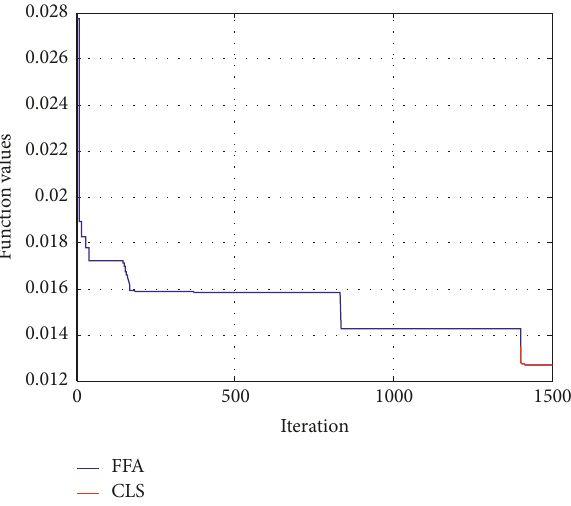
Figure 10: CFFA’s convergence curve of tension/compression spring design problem before and after CLS. Table 7: Friedman test ′ results for the engineering design